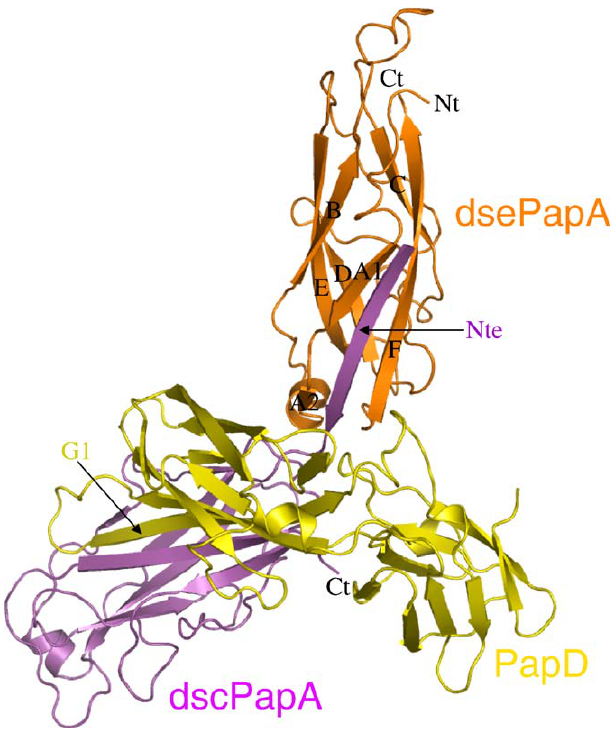
Figure 2. Crystal Structure of PapD/(PapA Ntd1_G15N_T101L ) 2 Overall 3-D structure of the PapD/(PapA Ntd1_G15N_T101L ) 2 complex: PapD (yellow), dscPapA (purple), and dsePapA (orange) are shown in ribbon representation with b -strand indicated as arrows and a -helices indicated as cylinders. The b -strands of dsePapA are labeled, as are the PapD G 1 strand and the dscPapA Nte. Figures 2–5 were made using PyMol (http://